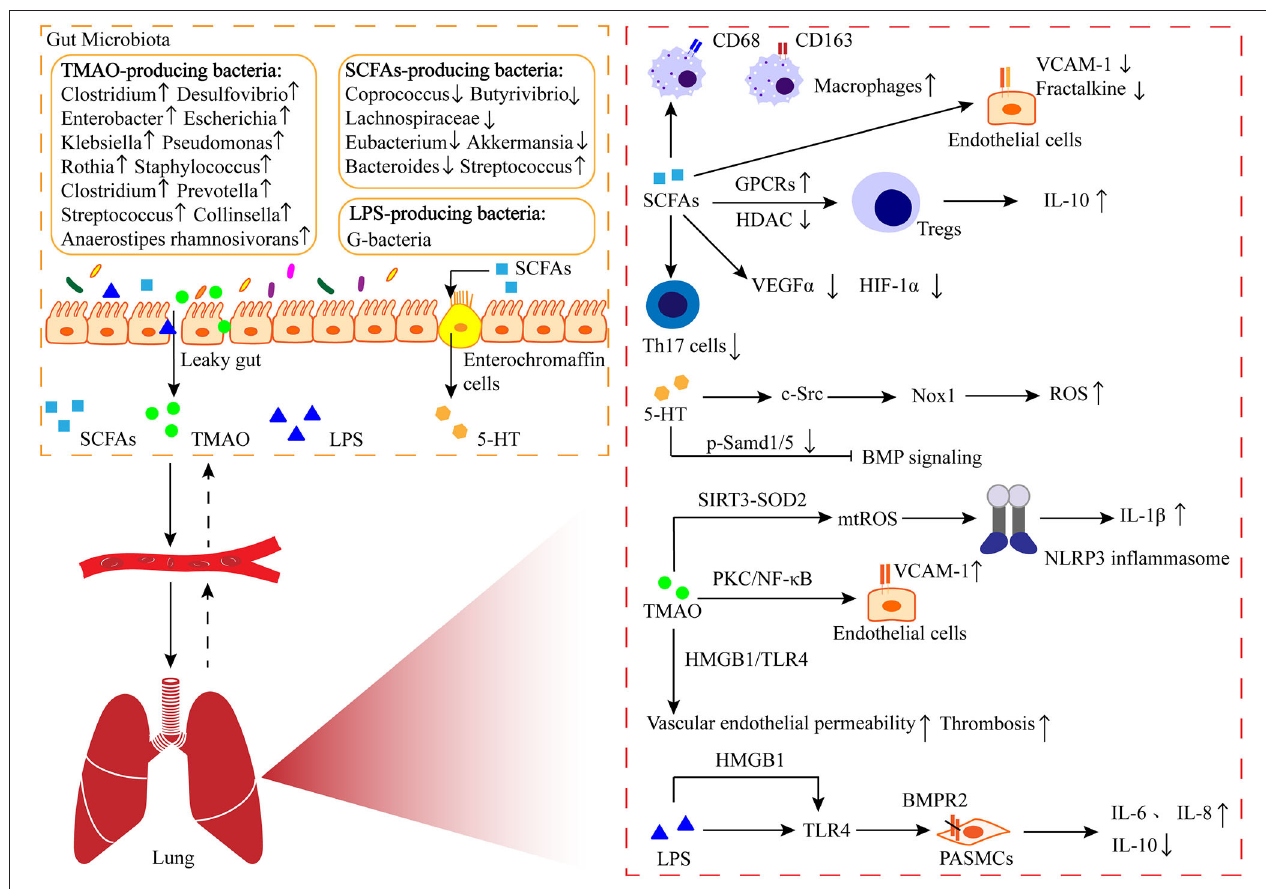
FIGURE 1 | The gut-lung axis in PAH. The metabolites like short-chain fatty acids (SCFAs) produced by intestinal bacteria enter the lungs through the circulation, where they are involved in immune regulation and play a role in perivascular inflammation and pulmonary vascular remodeling. 5-HT: serotonin; TMAO: trimethylamine N-oxide; LPS: lipo-polysaccharide; GPCRs: G protein-coupled receptor; HDAC: histone deacetylase; VCAM-1: vascular cell adhesion molecule-1; VEGF α : vascular endothelial growth factor α ; HIF-1 α : hypoxia-inducible factor-1 α ; Nox-1: NADPH oxidase-1; ROS: reactive oxygen species; SIRT3: sirtuin 3; SOD2: superoxide dismutases; NLRP3: nod-like receptor family pyrin domain containing 3; PKC: protein kinase C; NF- κ B: nuclear factor-kappa B; HMGB1: high-mobility group box-1; TLR4: toll-like receptor 4; BMPR2: bone morphogenetic protein receptor